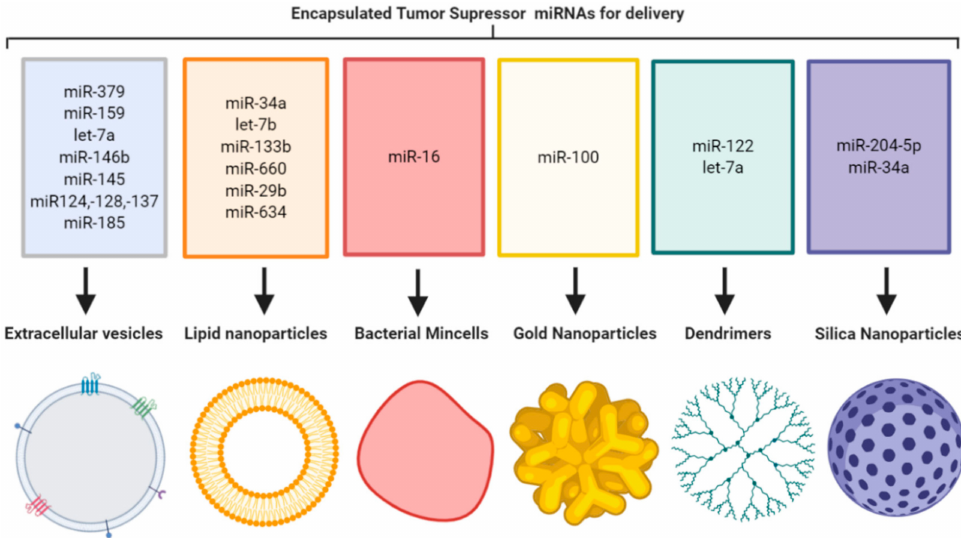
Figure 1. Tumor suppressor miRNA encapsulation in nanoparticle formulations for delivery to primary tumors and metastases (image created using Biorender.com—paid